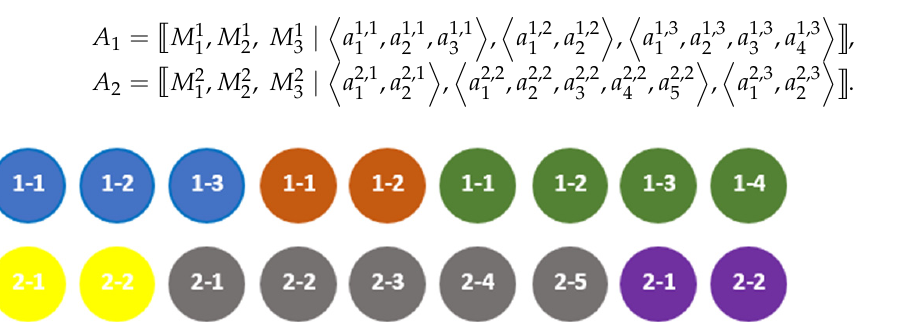
Figure 4. An example of two hiddenly compatible aggregates. Figure 3. An example of two incompatible aggregates. A special case of incompatibility is hidden